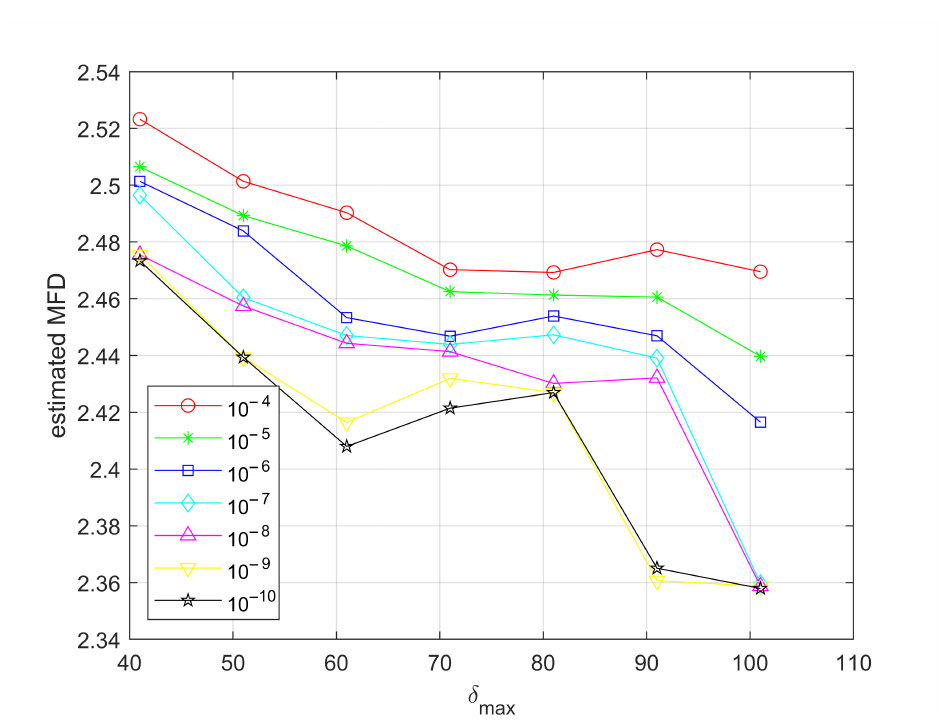
Figure 10. The estimated multi-spectral fractal dimension as a function of δ max for the low generated complexity ( H = 0.9) multi-spectral fractal image.